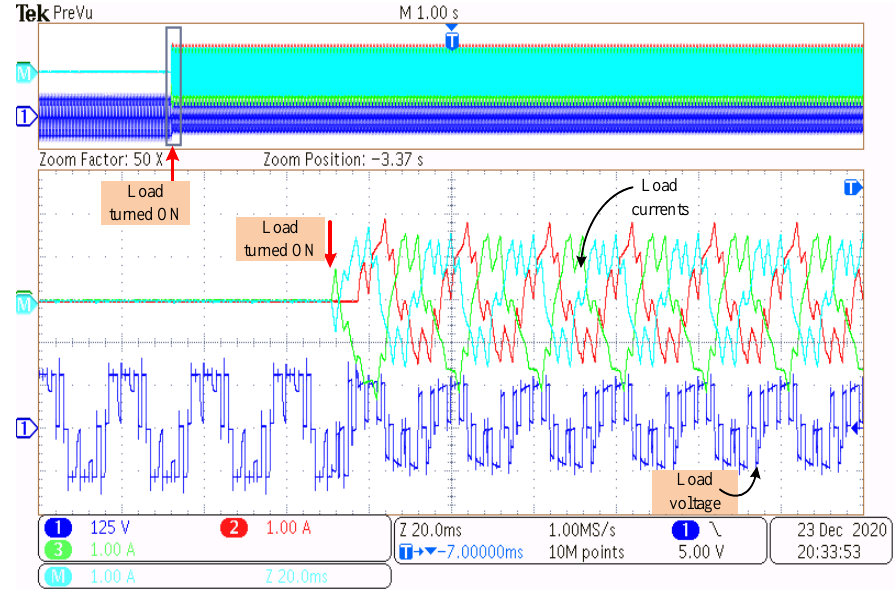
Figure 14. Experimental results using UVSVPWM under balanced load conditions.